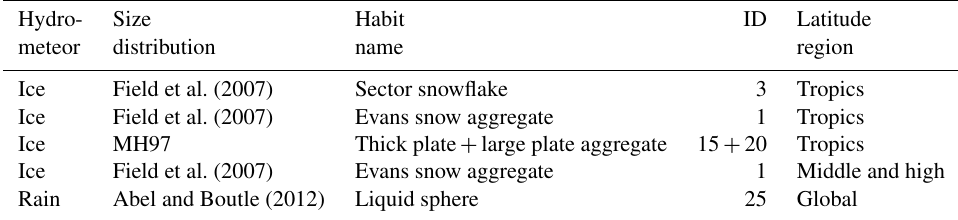
Table 2. Combinations of particle size distribution and habit model included in the test retrieval database. McFarquhar and Heymsfield (1997) is shortened to MH97. Field et al. (2007) defined a tropical and a mid-latitude version of their size distribution, and both are used. Each habit model consists of single scattering data selected from Eriksson et al. (2018), where both name and ID number are specified. Hydro- Size Habit ID Latitude